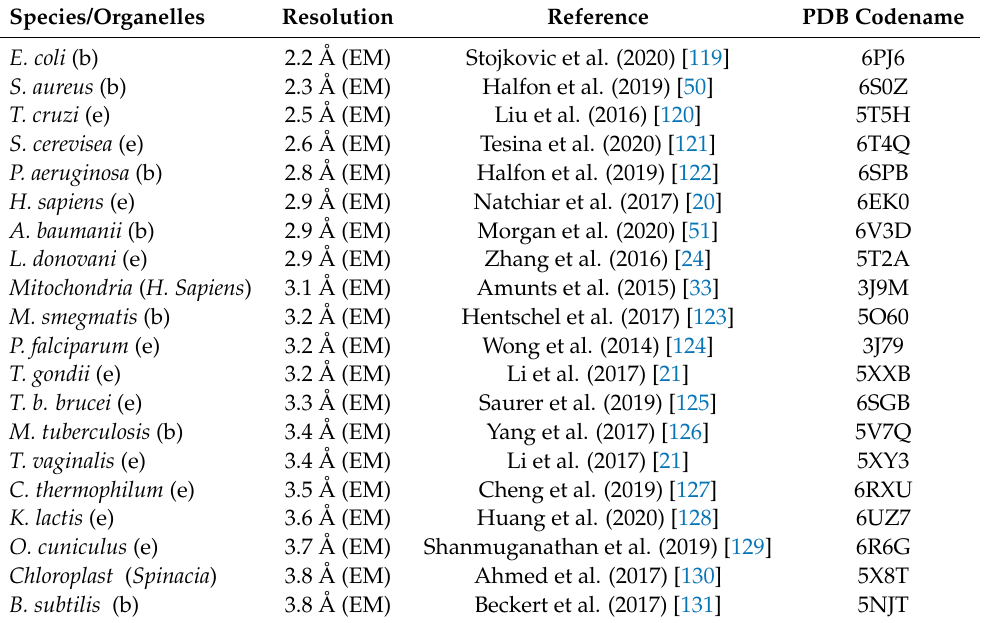
Table 1. Overview of species with ribosome cryo-EM structures solved at a resolution less than 3.8 Å. First column contains the species, with the domain they belong to (b: bacteria, a: archaea, e: